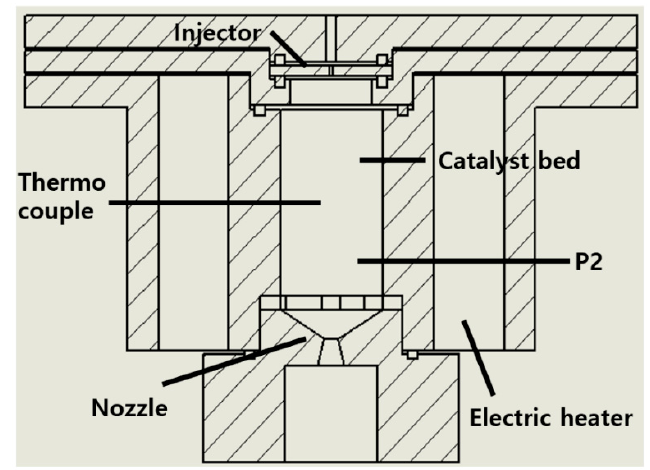
Figure 5. Schematic of the HAN thruster.